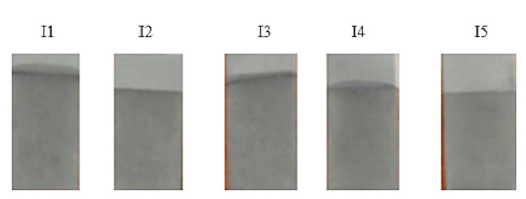
Figure 2. “I1”, “I2”, “I3”, “I4” and “I5” samples coated with Ni in the dark